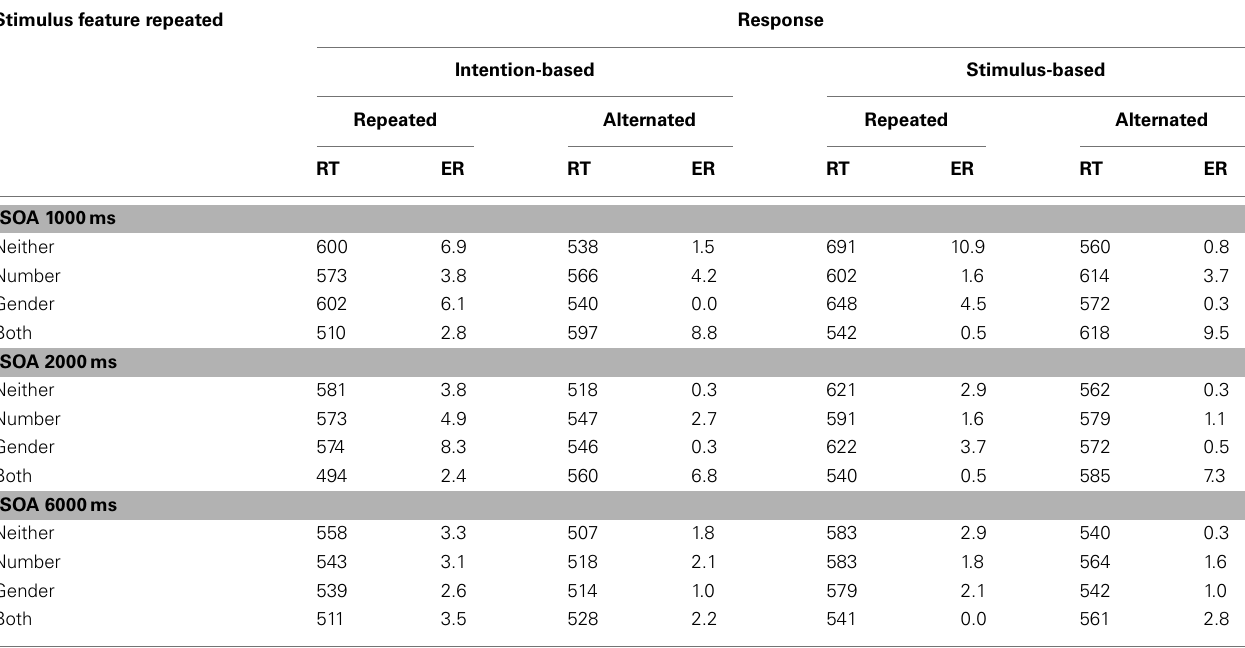
TableA3 | Means of mean reaction times (RTs, in ms) and error rates (ER) for R2 in Experiment 2 as a function of the relationship between S1 and S2 and between R1 and R2 and stimulus-onset asynchrony for intention-based and stimulus-based group. Stimulus feature repeated Response Intention-based Stimulus-based Repeated Alternated Repeated Alternated RT ER RT ER RT ER RT